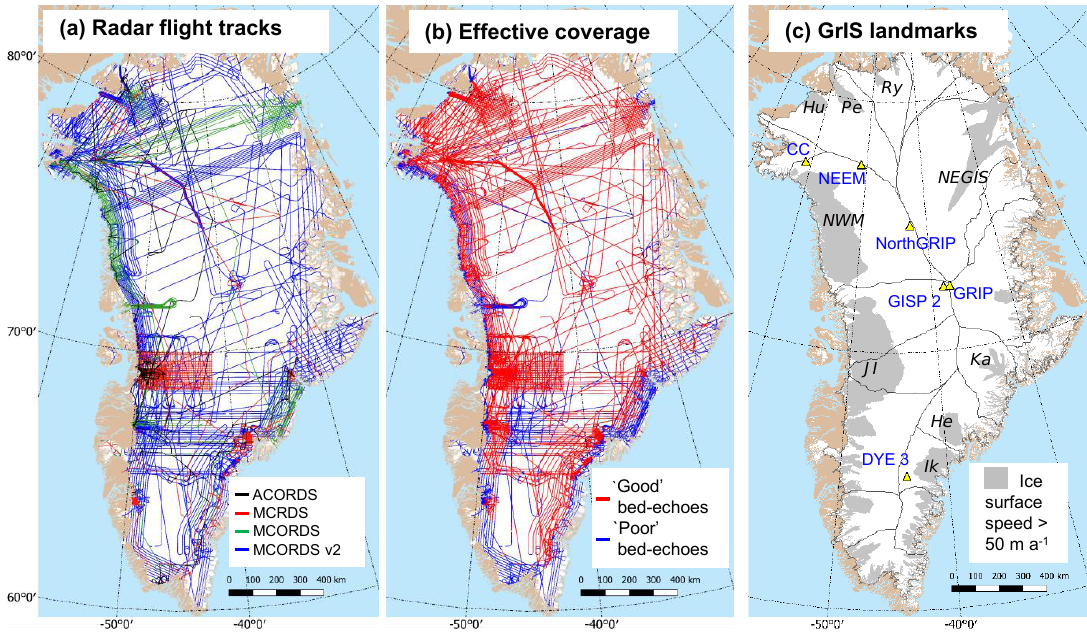
Figure 1. (a) Ice-penetrating radar flight tracks for different CReSIS radar systems. (b) Effective coverage for good-quality radar bed echoes (corresponding to peak power 10dB above noise floor). (c) Summary of key GrIS landmarks: temperature boreholes, major drainage basin boundaries (Zwally et al., 2012) and major regions of fast-flow identified from ice surface speed (Joughin et al., 2010, 2016). Abbreviations in (c) correspond to Camp Century (CC), Humboldt ( Hu ), Petermann ( Pe ), Ryder ( Ry ), Northeast Greenland Ice Stream ( NEGIS ), north-western margins ( NWM ), Jakobshavn Isbræ ( JI ), Kangerlussuaq ( Ka ), Helheim ( He ) and Ikertivaq ( Ik ). The projection is a polar stereographic north (70 ◦ N, 45 ◦ W) and is used in all future